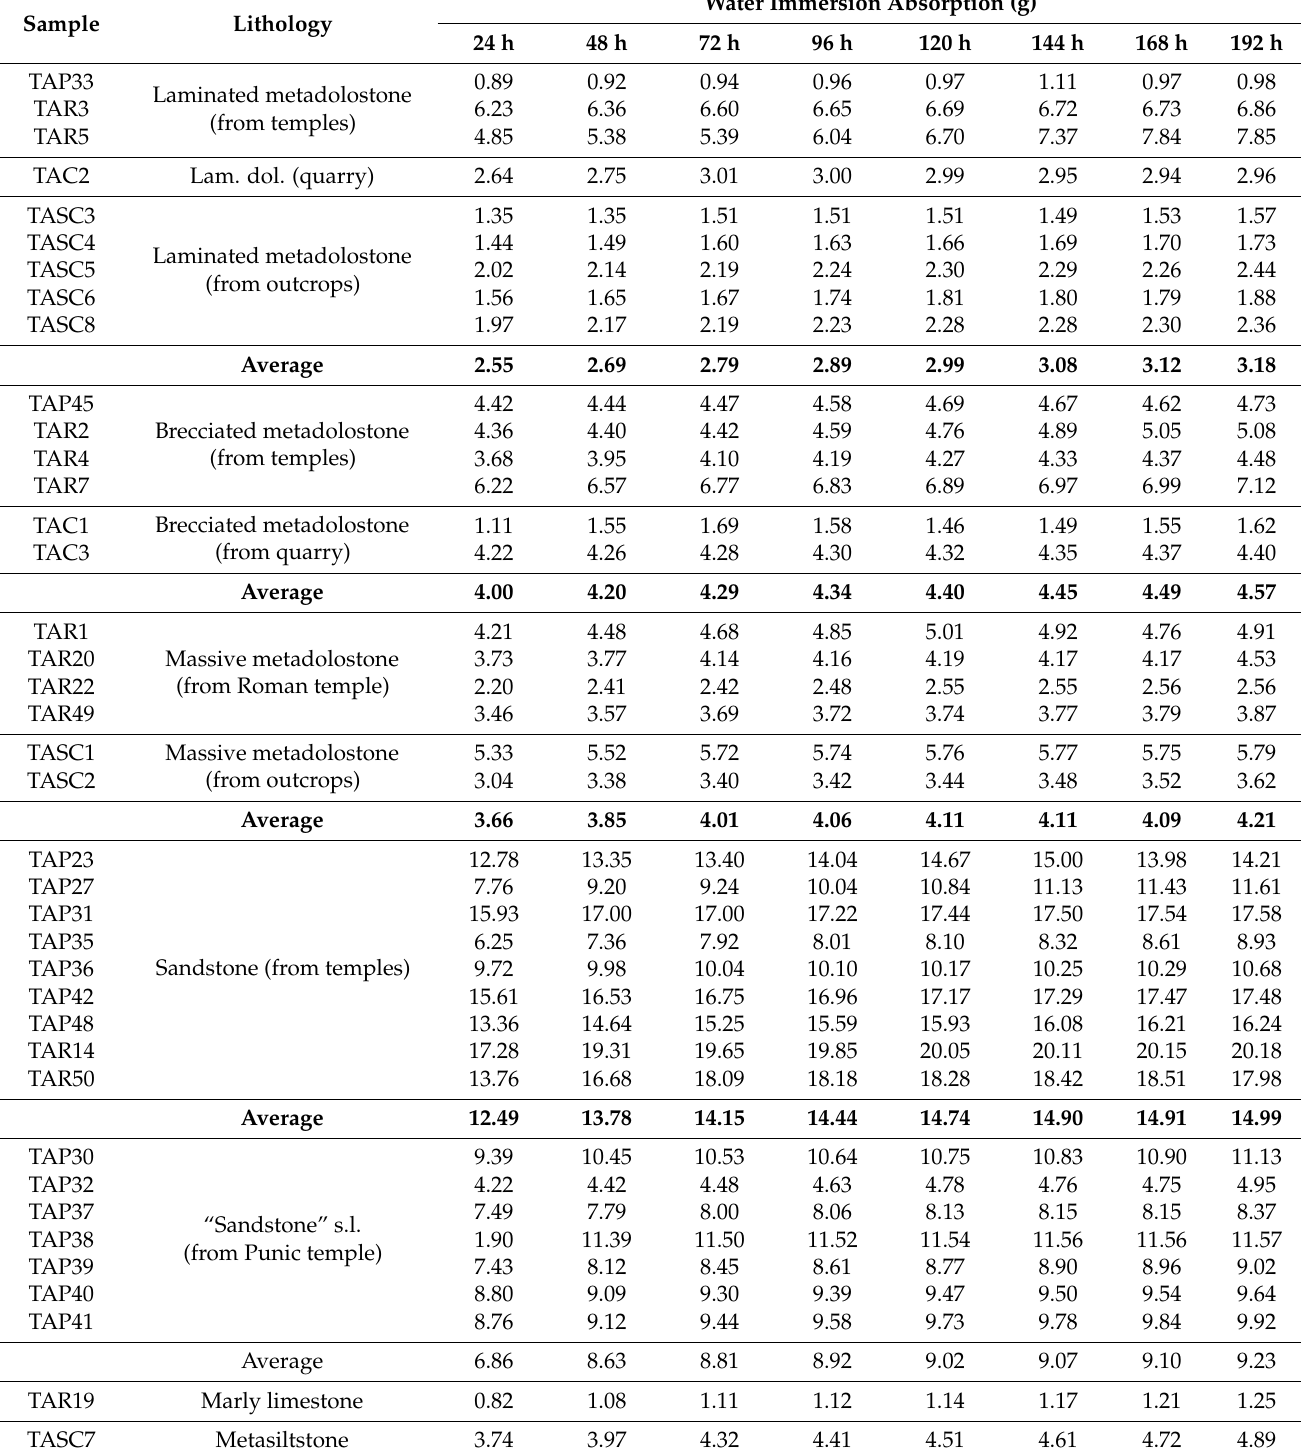
Table 3. Data of kinetic water absorption during the time for 192